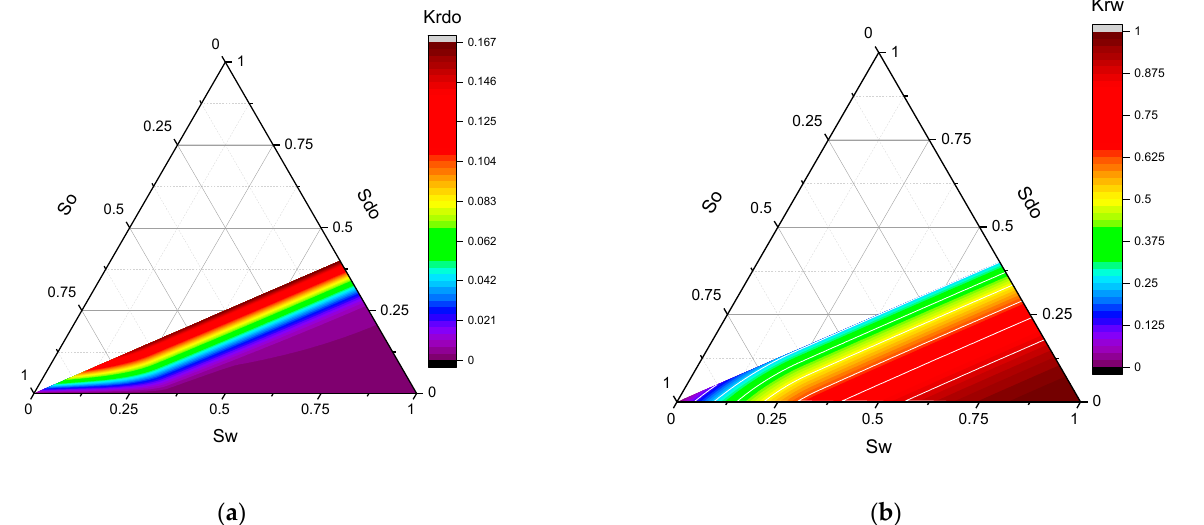
Figure 11. The relative permeability ternary diagrams of dispersed oil and continuous water phase when φ d = 0.4, λ = 0.6, and Ca = 10 − 3 . ( a ) Dispersed oil; ( b ) continuous water.